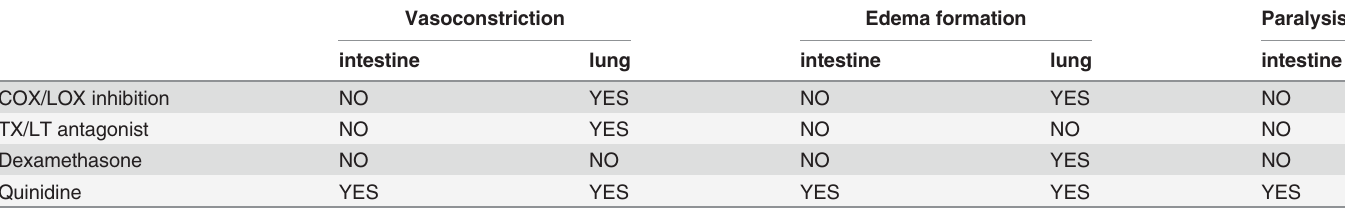
Table 1. Effects of drugs on organ dysfunction in the isolated perfused rat intestine and in the isolated perfused rat